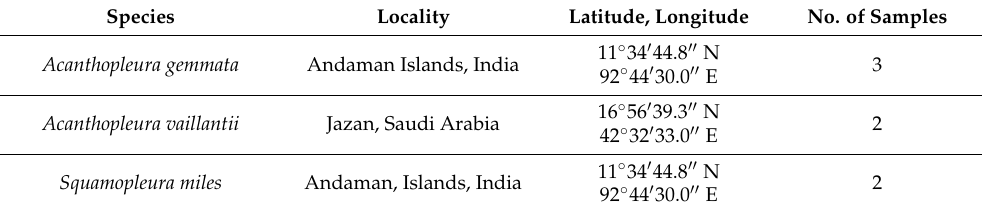
Table 2. Details of sampling